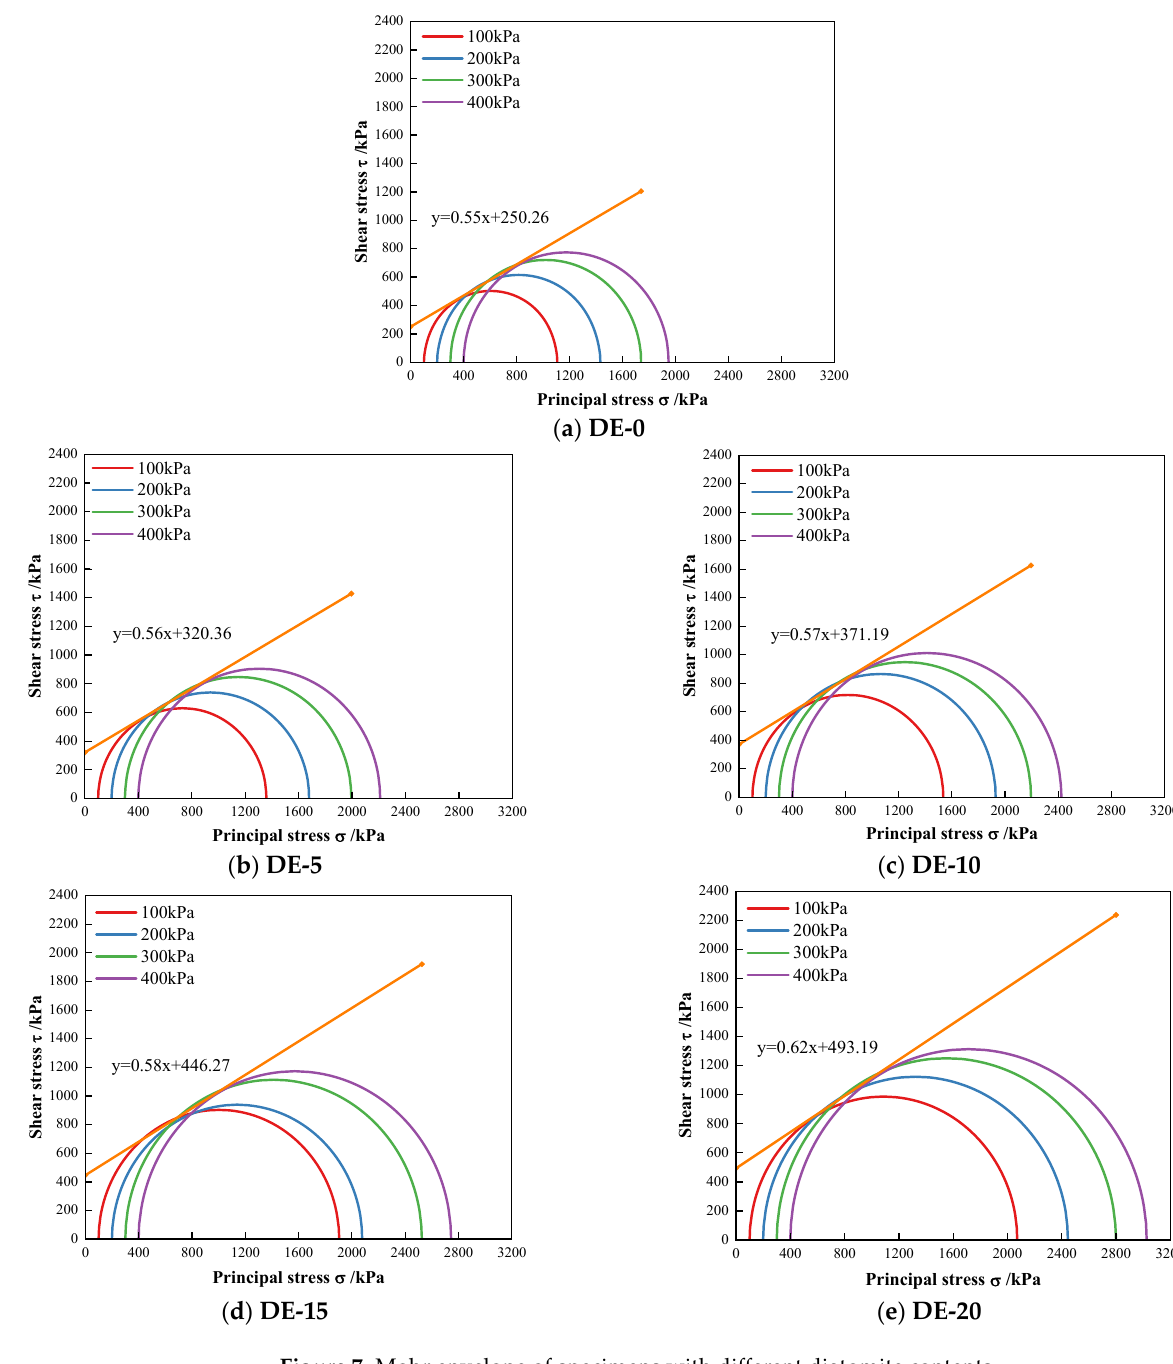
Figure 7. Mohr envelope of specimens with different diatomite contents.